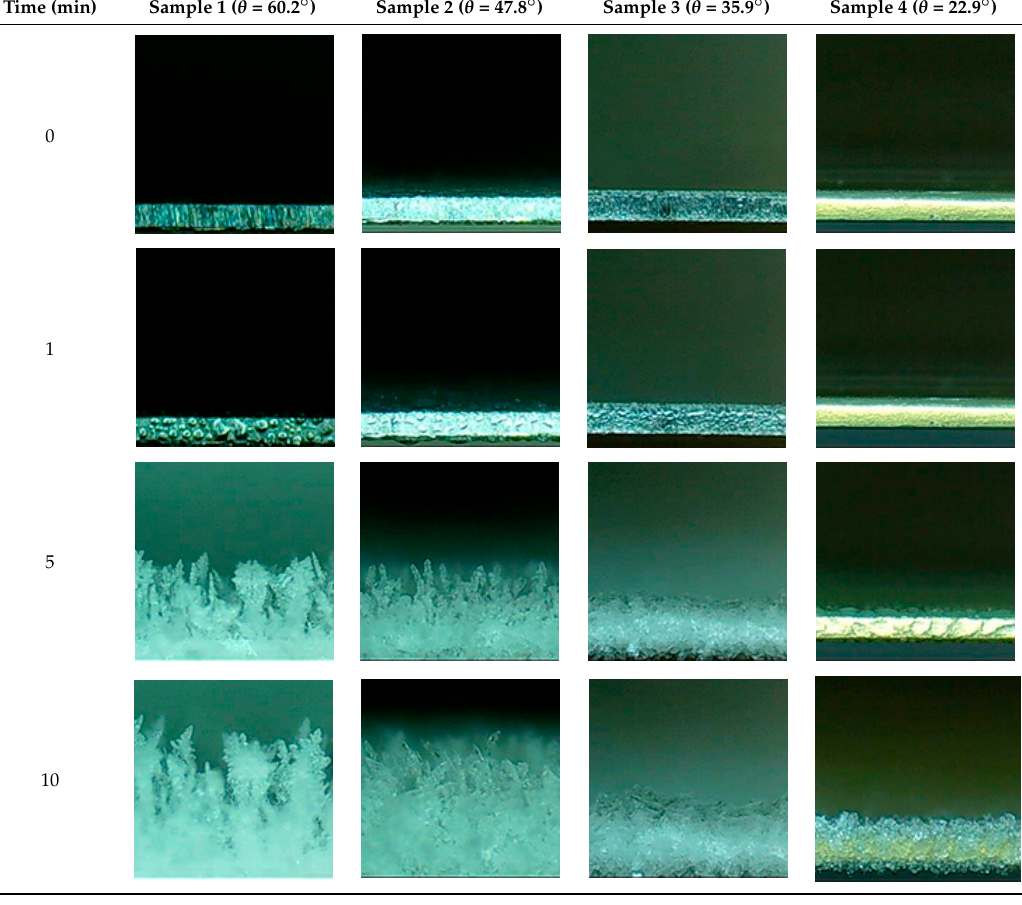
Table 5. The structure of the frost layer on the side of the aluminum sheets at T s = − 15 °C, T a = 5 °C, and φ = 60%.